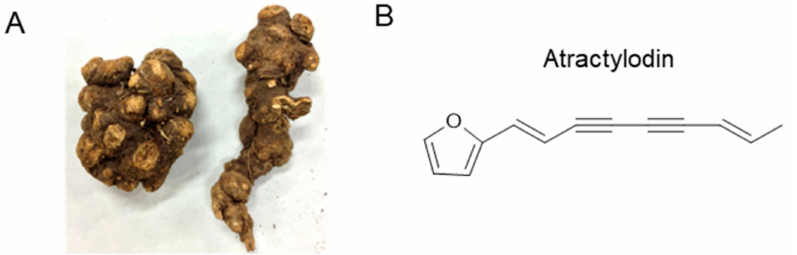
Figure 1. Source and structure of atractylodin (ATR). ( A ) Rhizomes of Atractylodes lancea De Candolle. ( B ) Chemical structure of